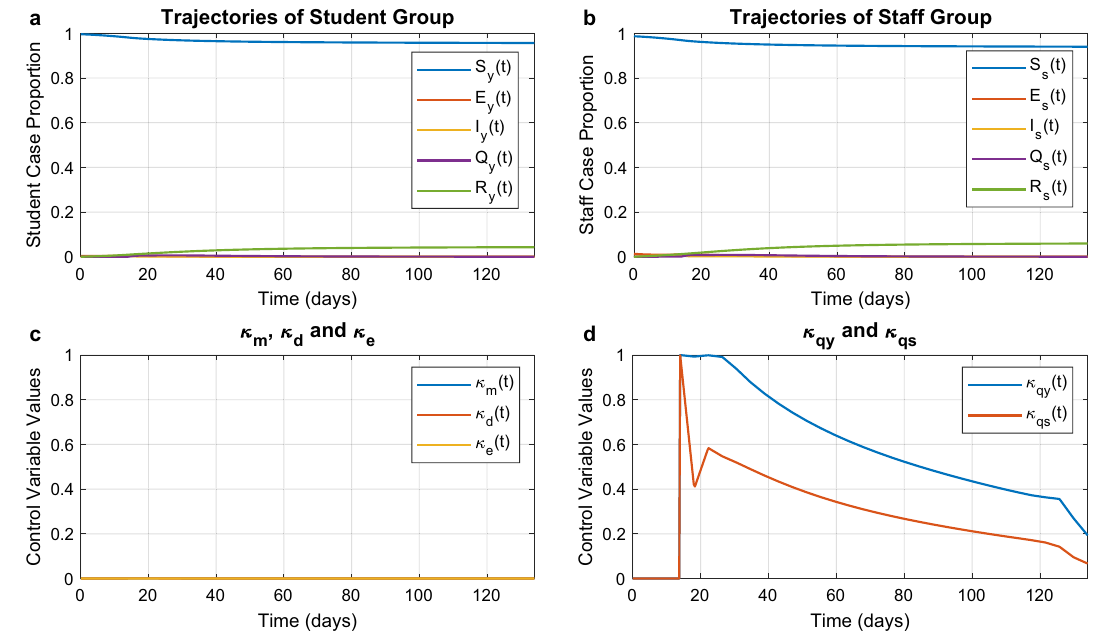
Figure 5. Optimal trajectories for minimum use of non-quarantine interventions. Optimal trajectories when the departments would like to minimise use of masks, social distancing and environmental disinfection. ( a ) and ( b ) The epidemic evolution among students and staff, respectively. ( c ) The optimal strategies for mask wearing ( κ m ), social distancing ( κ d ), and environmental disinfection ( κ e ). ( d ) The optimal strategies for mandatory quarantine on infected students ( κ qy ) and infected staff ( κ qs ).